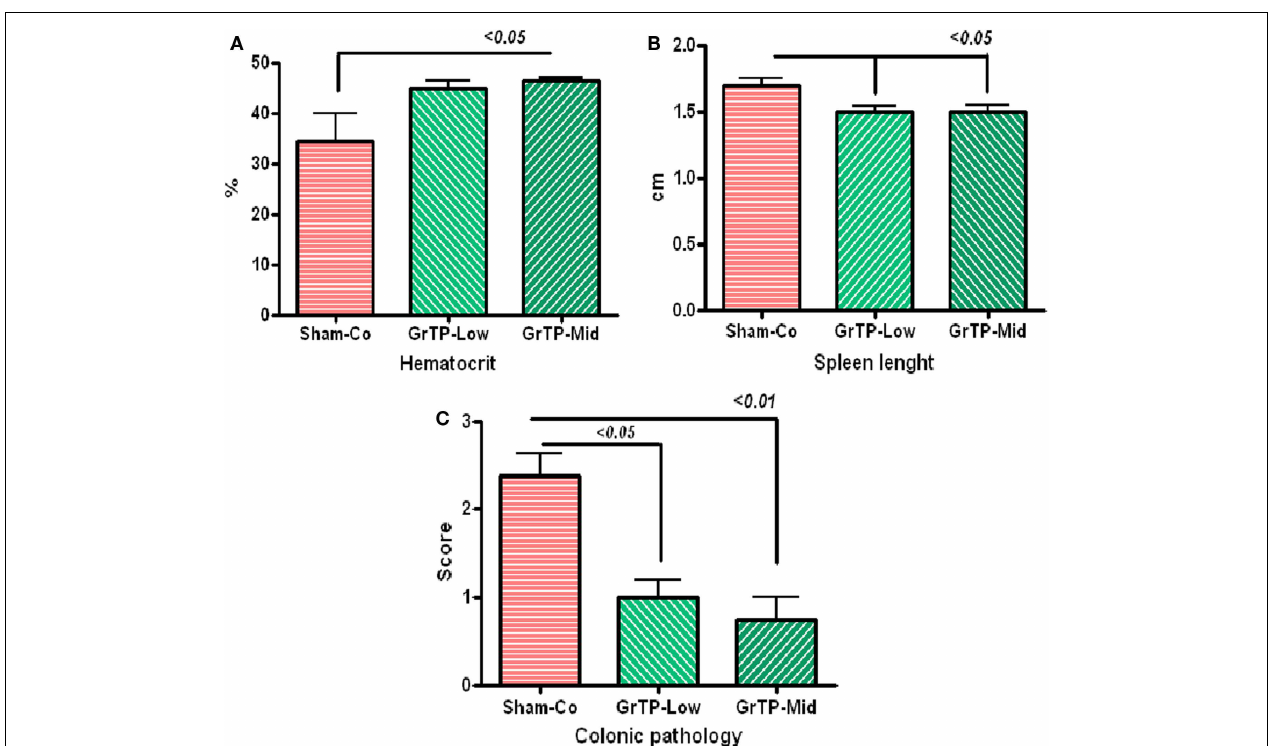
(B) IL-10 deficient mice had enlarged splenic tissue due to infiltration of inflammatory cells and GrTP significantly reduced the inflammatory response. (C) IL-10 deficient mice developed spontaneous enterocolitis and rectal prolapsed. GrTP significantly ameliorated the pathological